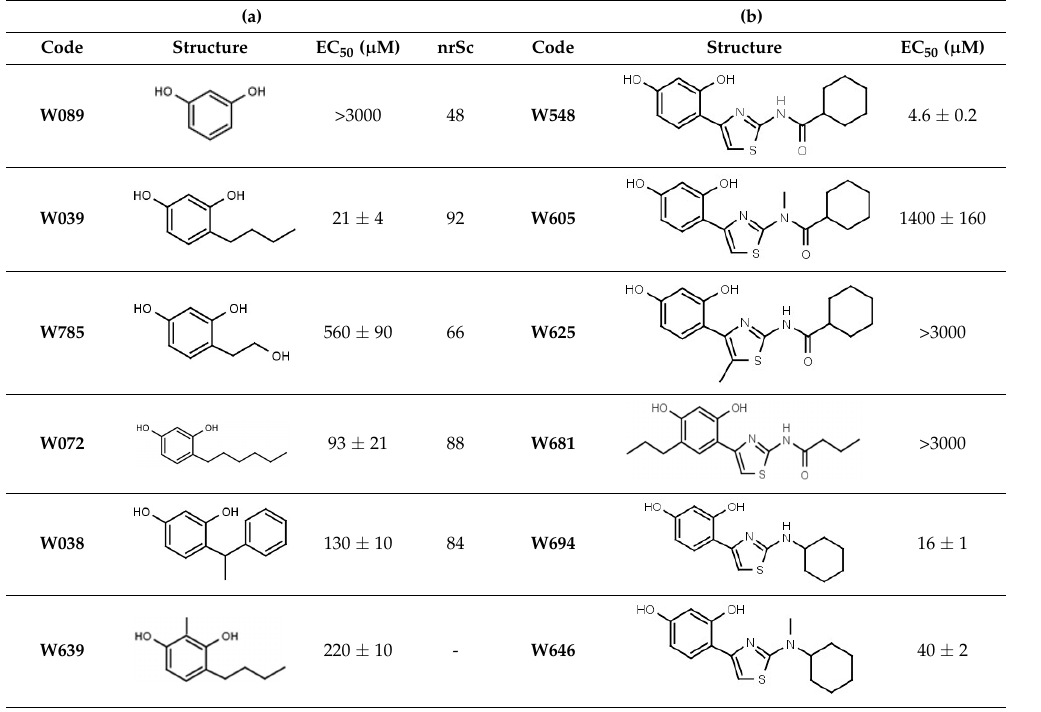
Table 3. Inhibitory activities (as EC 50 ) of ( a ) resorcinol and 4-alkyl resorcinols; and ( b ) methylated thiazolyl resorcinols. nrSc—negative rerank Score estimated by MVD.